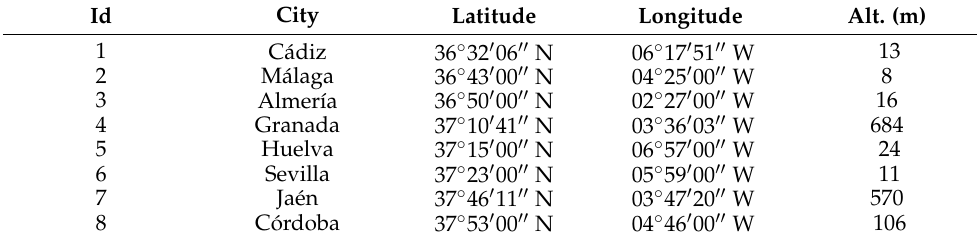
Table 2. Cities under